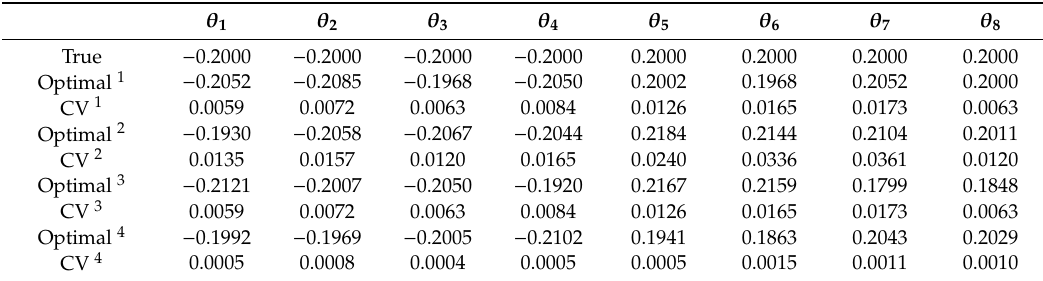
Table 1. The identified results of the model parameters.